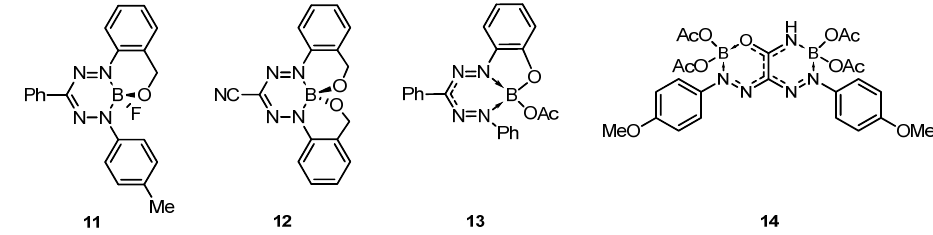
Figure 2. Examples of various boron formazanates.